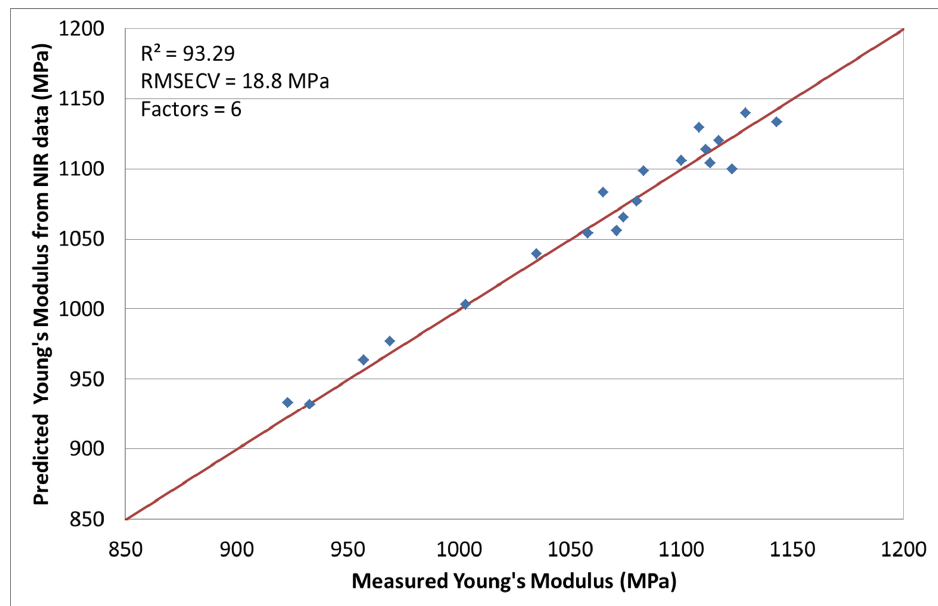
Figure 3. Predicted Young’s modulus values by NIR versus measured.